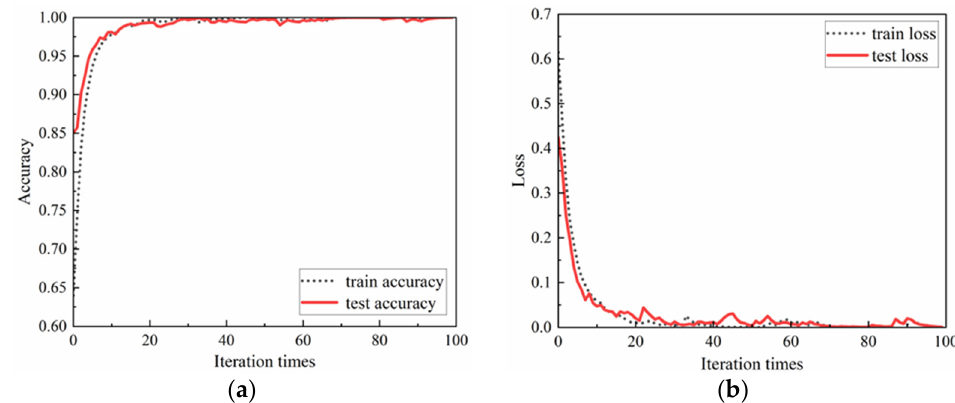
Figure 15. Accuracy and loss rates for multiple tests.